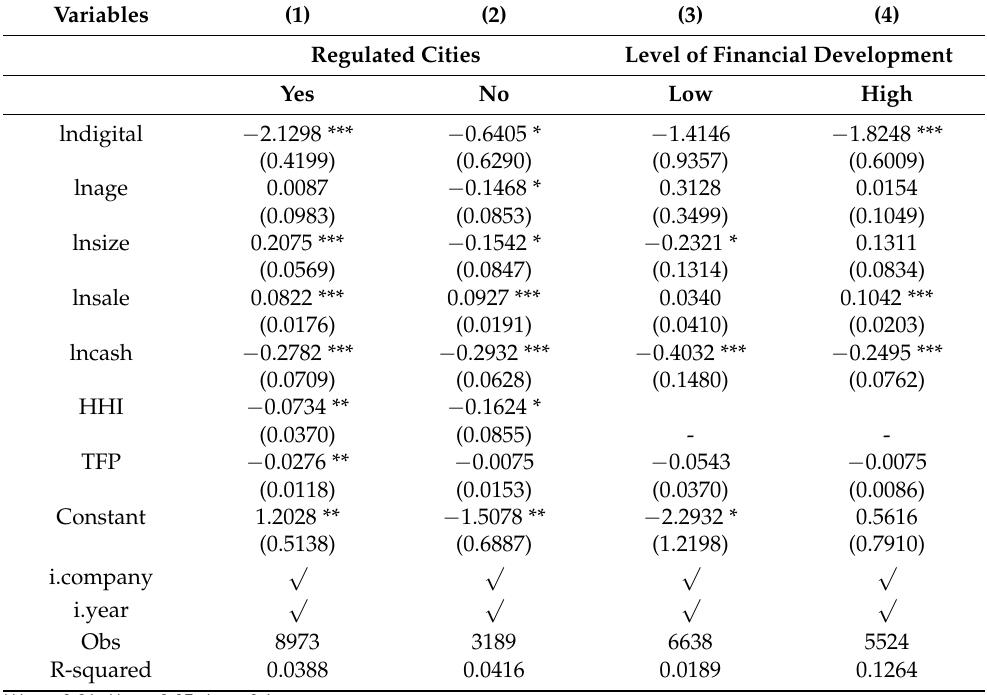
Table 6. Environmental regulation and financial